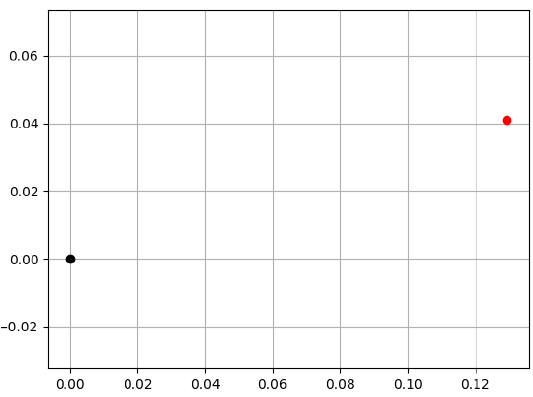
Figure 15. Fitting results. Table 8. Bolt preload comparison (unit: